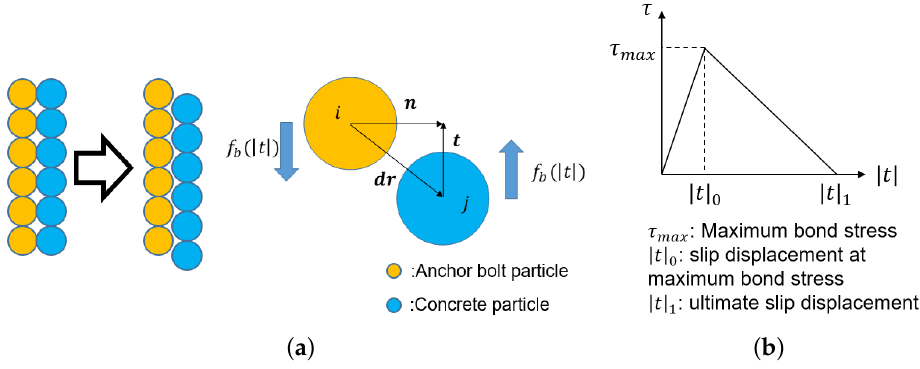
Figure 3. Calculation of bond stress. ( a ) Slip displacement between steel particle and concrete particle. ( b ) Relationship between slip displacement and bond stress abutment.